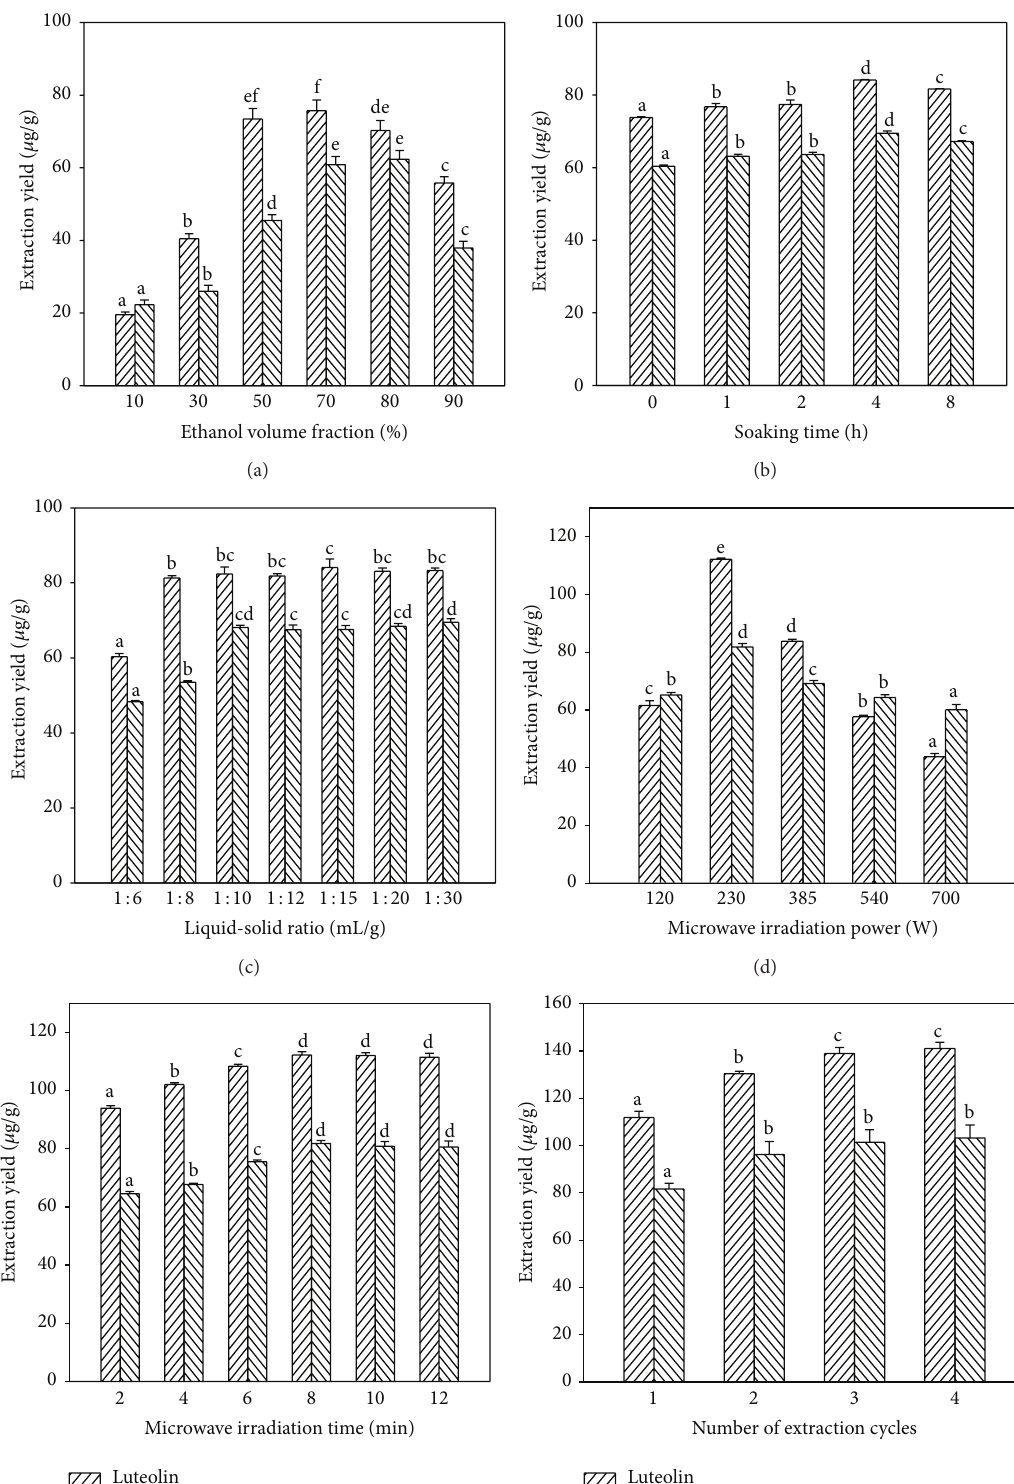
Figure 2: The influence conditions ((a): ethanol volume fraction; (b): soaking time; (c): liquid-solid ratio; (d): microwave irradiation power; (e): microwave irradiation time; (f): number of extraction cycles) on the extraction yields of luteolin and apigenin. The values represent means ± standard deviation. Values followed by the same letter in the same assay are not significantly different ( 𝑃 > 0.05 , 𝑛 = 3